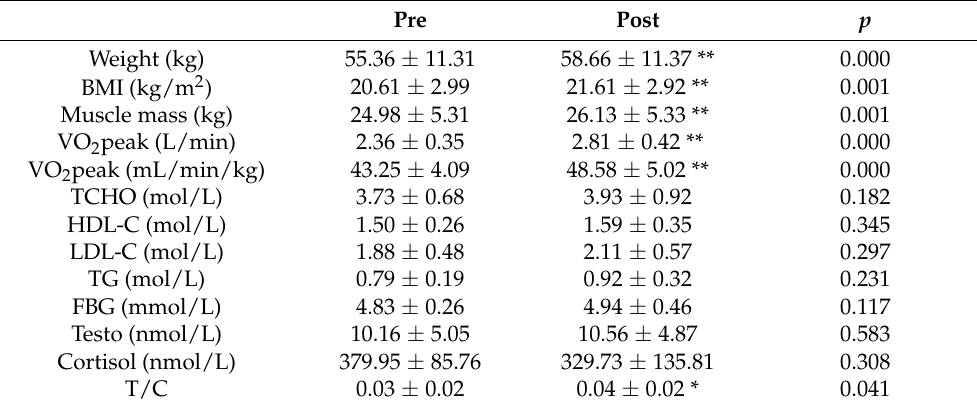
Table 1. Anthropometric, exercise, and biochemical characteristics pre- and post-sprint interval training.